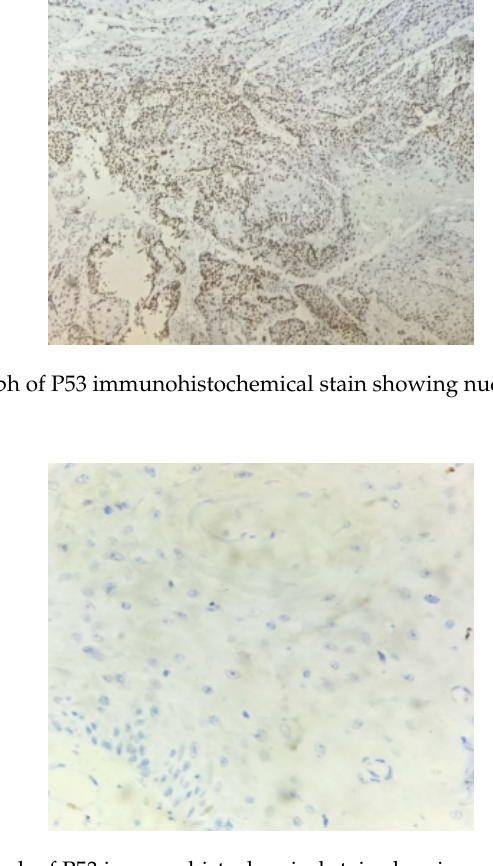
Figure 3. Photomicrograph of P53 immunohistochemical stain showing nuclear positivity (40X